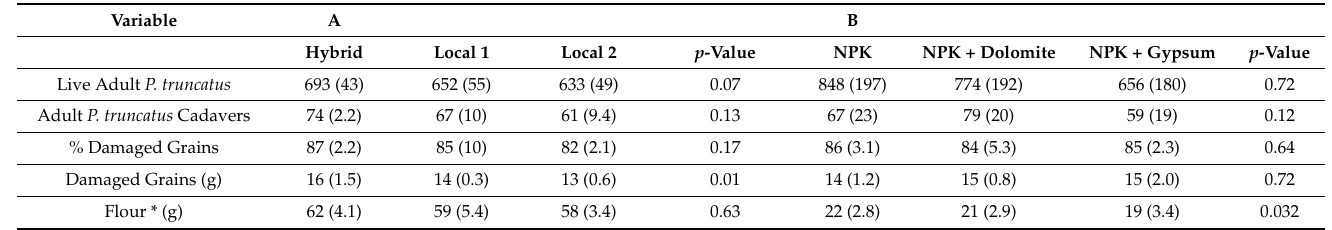
Table 2. Differences among maize varieties ( A ) and among fertilizer treatments ( B ) in the number of live adult P. truncatus , and adult P. truncatus cadavers, percentage of damaged grains, and weight of damaged grains after an P. truncatus infestation period of 12 weeks.